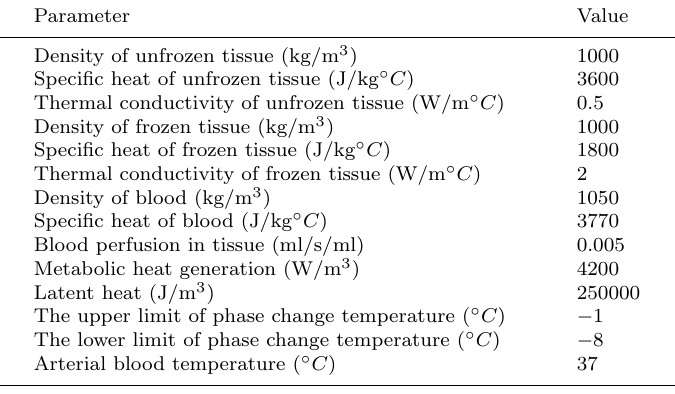
Table 1. Thermal properties of tissue. Parameter